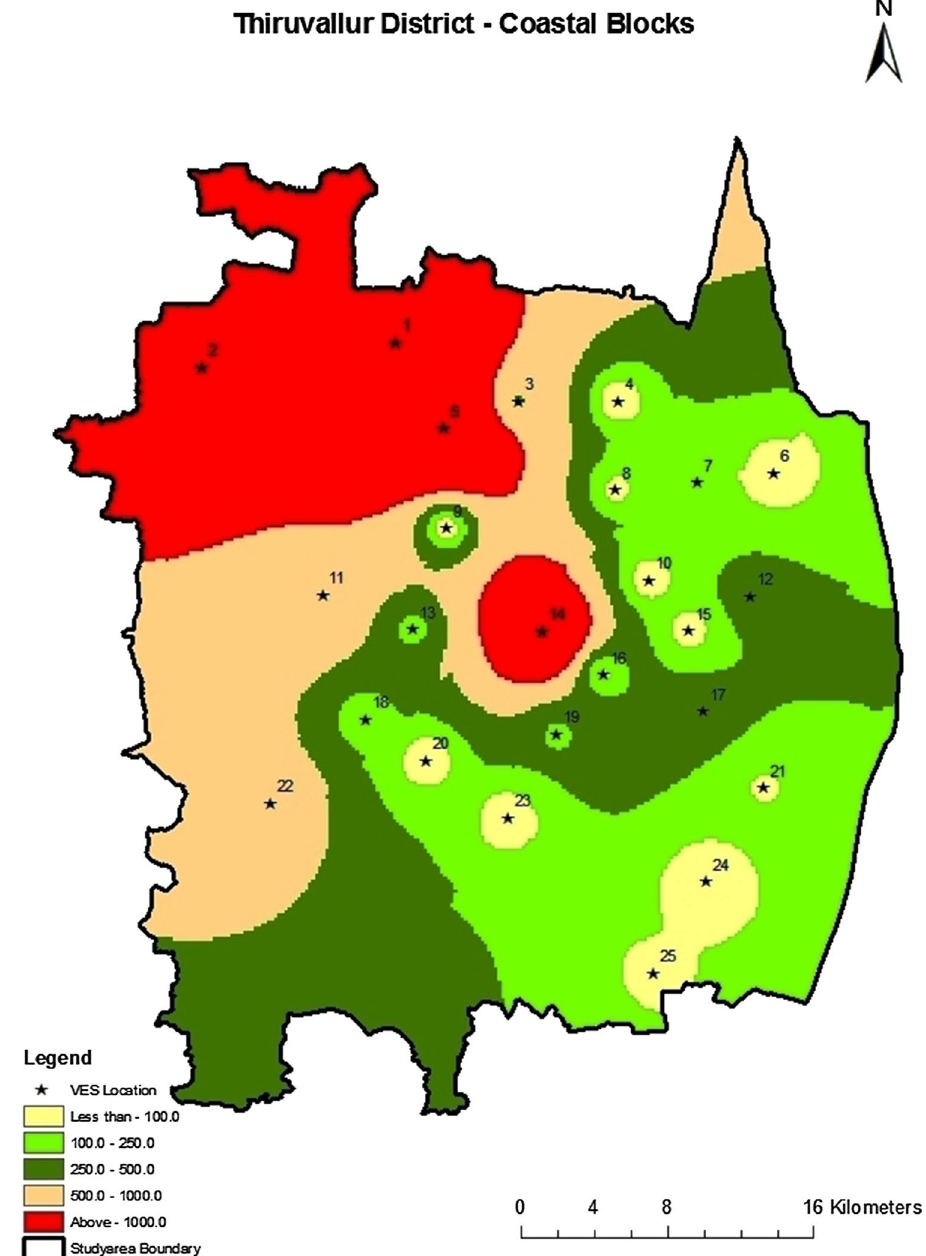
Fig. 13 Transverse resistance ( T )